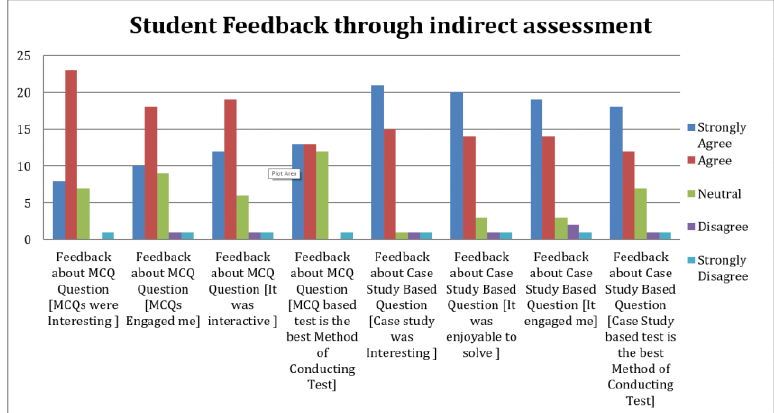
Fig. 3. Bar Graph of students’ feedback through indirect